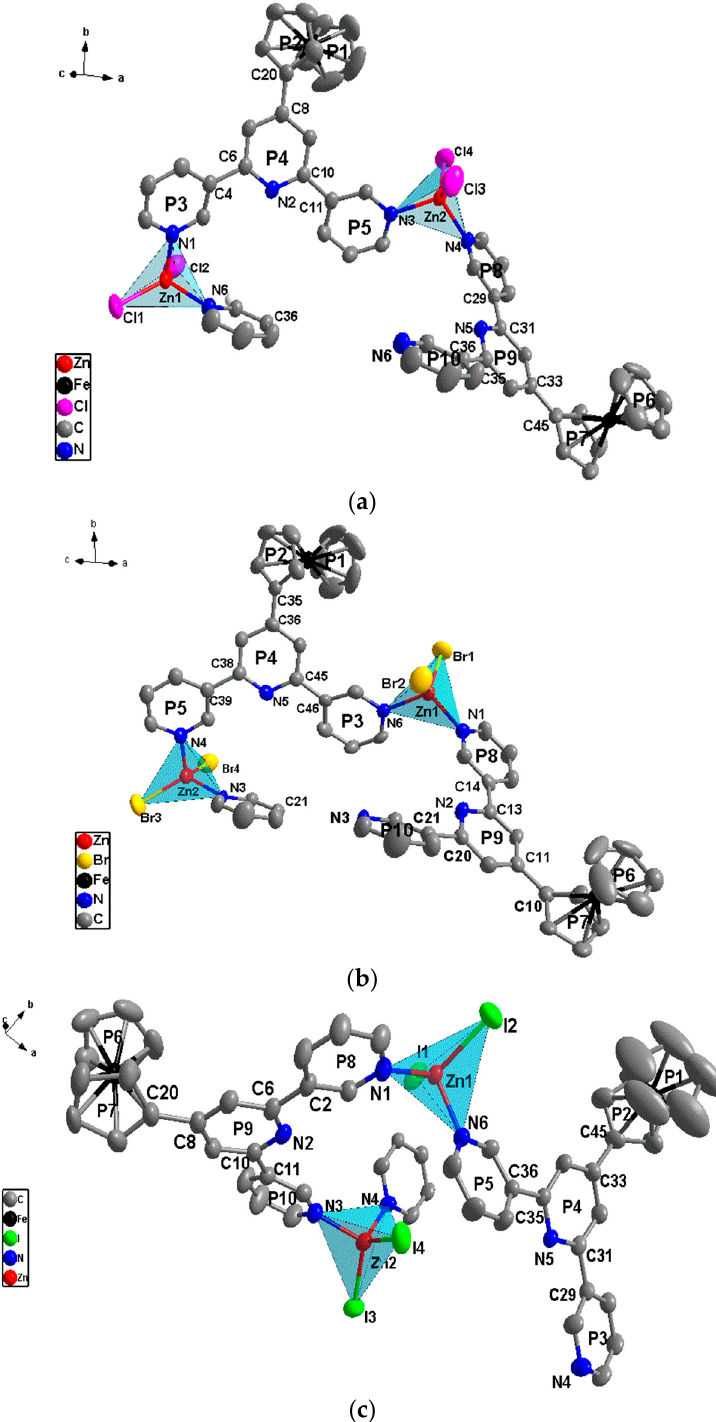
Figure 4. The coordination environment of the Zn II ion in complexes 1 ( a ), 2 ( b ) and 3 ( c ) with atom part numbering and ring labeling (H atoms and solvent molecules are omitted for clarity).